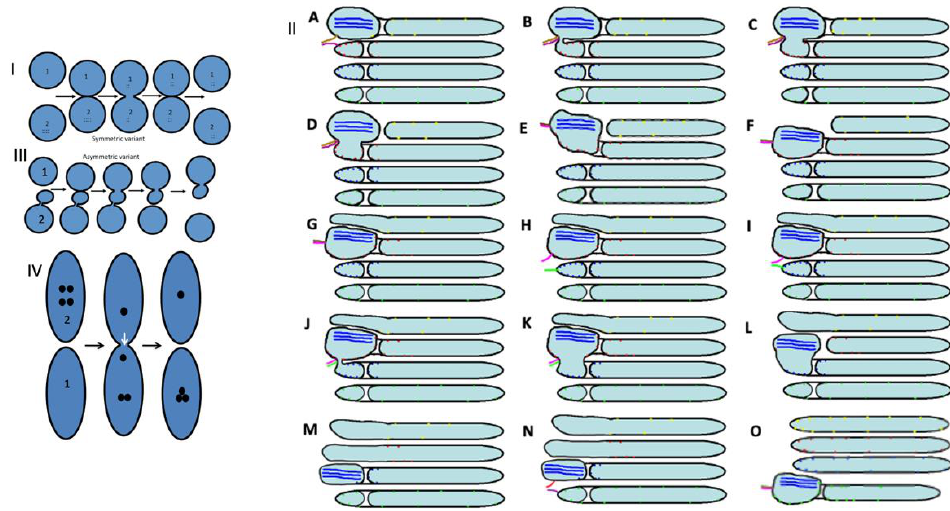
Figure 2. Schemes of the kiss-and-run models of intracellular transport ( I – IV ) and ( A – O ). Adapted from Mironov and Beznoussenko [38]. ( I ) The symmetrical KARM poses that after fusion of the membranes of these two compartments (central image), cargo (black dots inside the ring 2) would diffuse into the lumen of compartment 1. The concentration of cargo would be similar in both compartments. ( II ) The asymmetric KARM poses that distal compartment 2 is composed of the main part and smaller parts where the cargoes are concentrated. These two parts are connected by thin tubules. Thus, the KARM suggests that the compartments initially fuse, and then for some reason, the tubules undergo fission. For instance, these tubules can be broken easily when lipids from the distal compartment diffuse into them. An additional demand for the asymmetrical KARM is the necessity for a mechanism responsible for the change in the cargoes in such a way that this would induce a greater formation of temporal aggregates by the cargoes. These temporally existing aggregates would be not able to diffuse through the thin tubules backwards. ( A – O ) Function of the asymmetrical KARM within the Golgi stack (see Movie S1). ( A ) Formation of the SNARE complex composed of V- and T-SNAREs (brown and magenta lines, left) between the mega-cargo (blue lines) containing cisternal distensions and the rim of the distal cisterna. ( B ) Fusion between the distensions and the corresponding rim. ( C – F ) Integration of the distension into the distal cisterna. ( G ) Elongation of the first cisternae. ( H , I ) Replacement of the SNAREs and formation of the new SNARE complex composed of another set of SNAREs (red and green line). ( J ) Fusion of the cargo-containing distension situated within the second cisterna with the rim of the third cisterna containing a pore. ( K – O ) Additional rounds of fusion/fission processes.